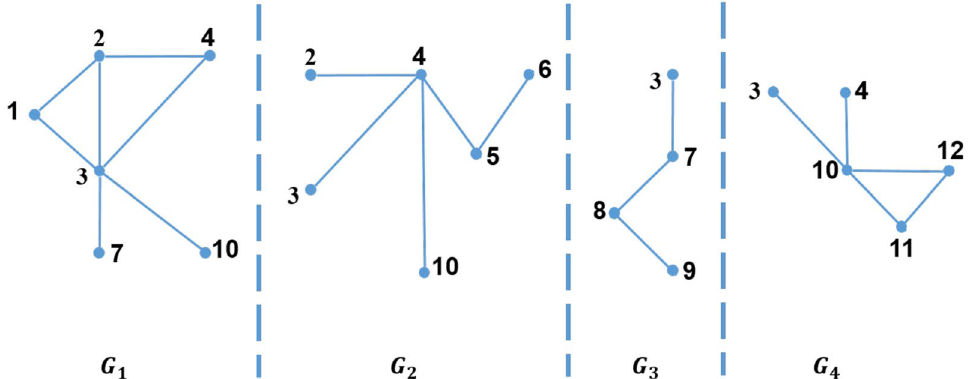
Figure 6. 1-partition of the graph in Fig. 2 using OTP.